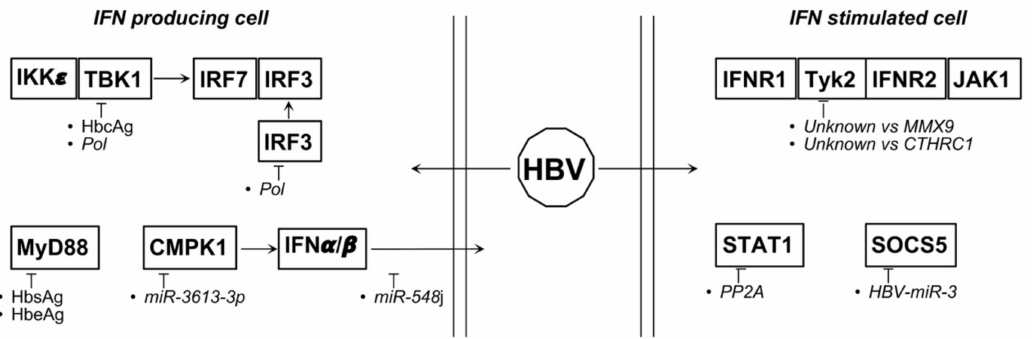
Figure 6. Proteins and miRNAs able to deregulate type I IFNs relevant pathways during HBV associated tumorigenesis. Italics represent indirect